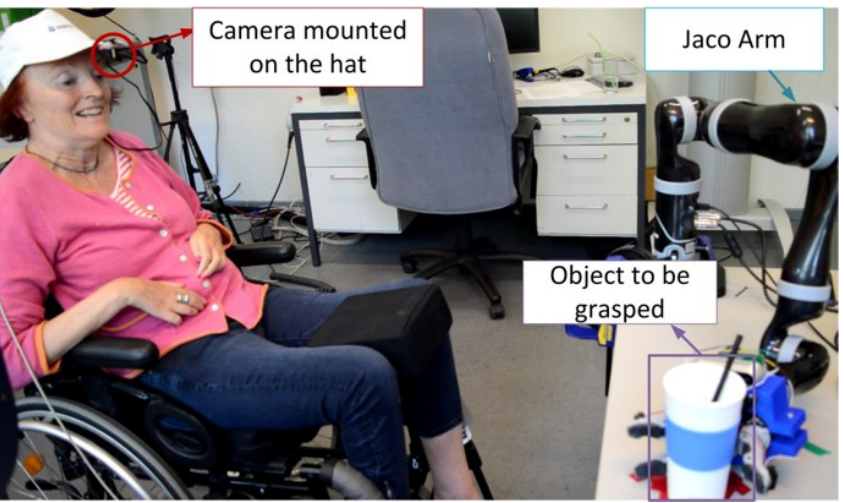
Figure 9. The Jaco 2 learns how to serve a drink from a person with quadriplegia via a head gesture-based human–robot interface